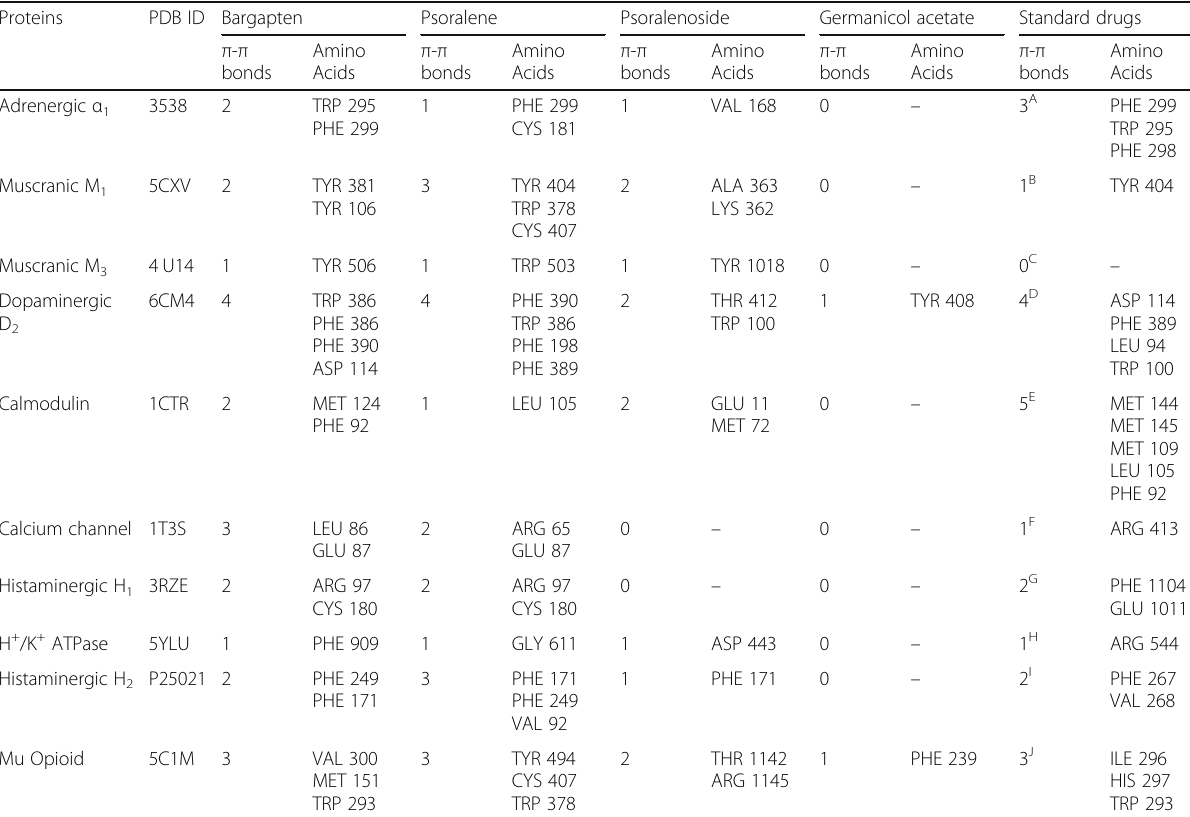
Table 6 Pi-Pi bonds (p-p bonds) formed by Bargapten, Psoralene, Psoralenoside, Germanicol acetate and standard drugs against targets: adrenergic α 1 receptor, muscranic M 1 , muscranic M 3 , dopaminergic D 2 , calmodulin, mu-opioid, voltage gated L-Type calcium channel, histaminergic H 1 , histaminergic H 2 and H + /K + ATPase